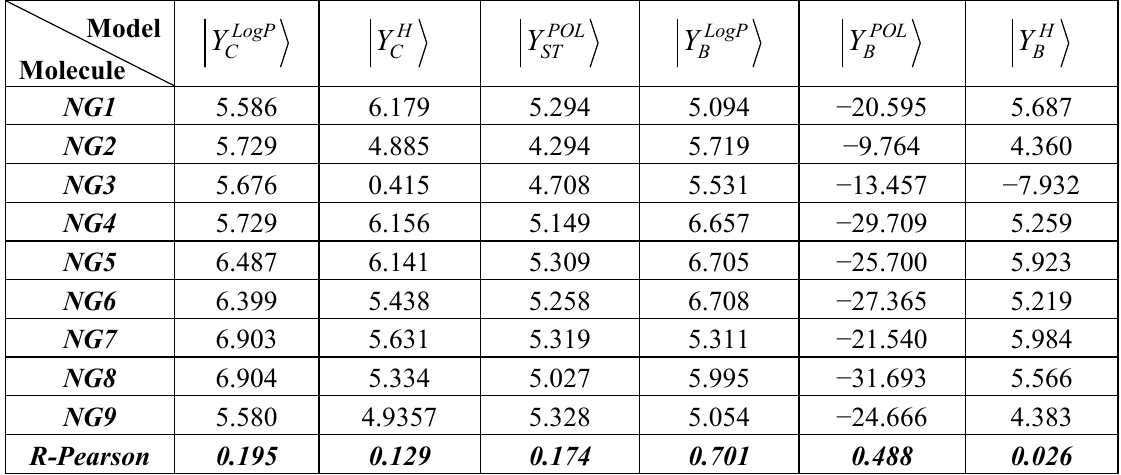
Table 10. Predicted activity as computed for the non-Gaussian molecules of Table 4 with the models of Table 5 founded along the minimum paths of Table 7; for each predicted model, its correlation with the observed activity is indicated at the bottom of the table.